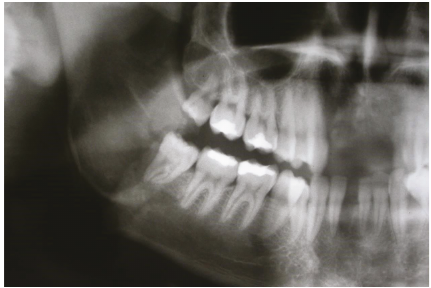
Figure 1: Orthopantomography demonstrating incorrect union of the fractured extremities in the right quadrant mandibular angle.